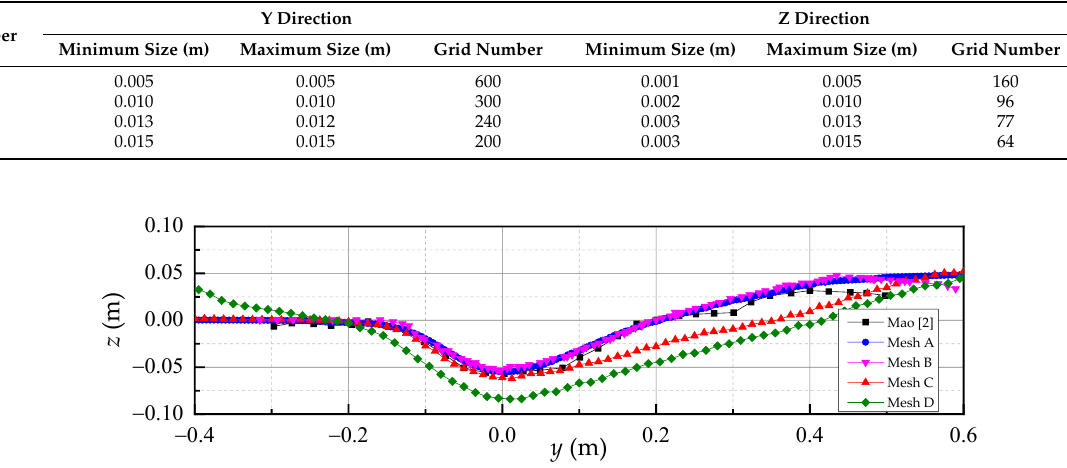
Table 2. Cases for mesh sensitivity analysis.